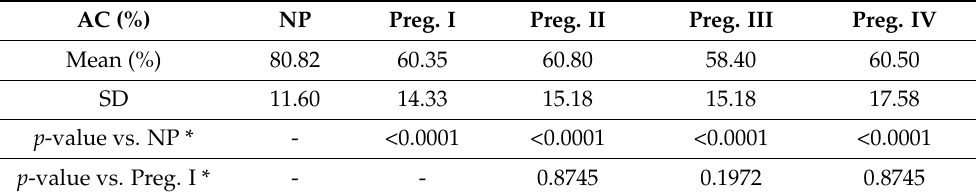
Table 2. Antioxidant capacity (AC) in the saliva of pregnant women at different gestational ages and non-pregnant women.